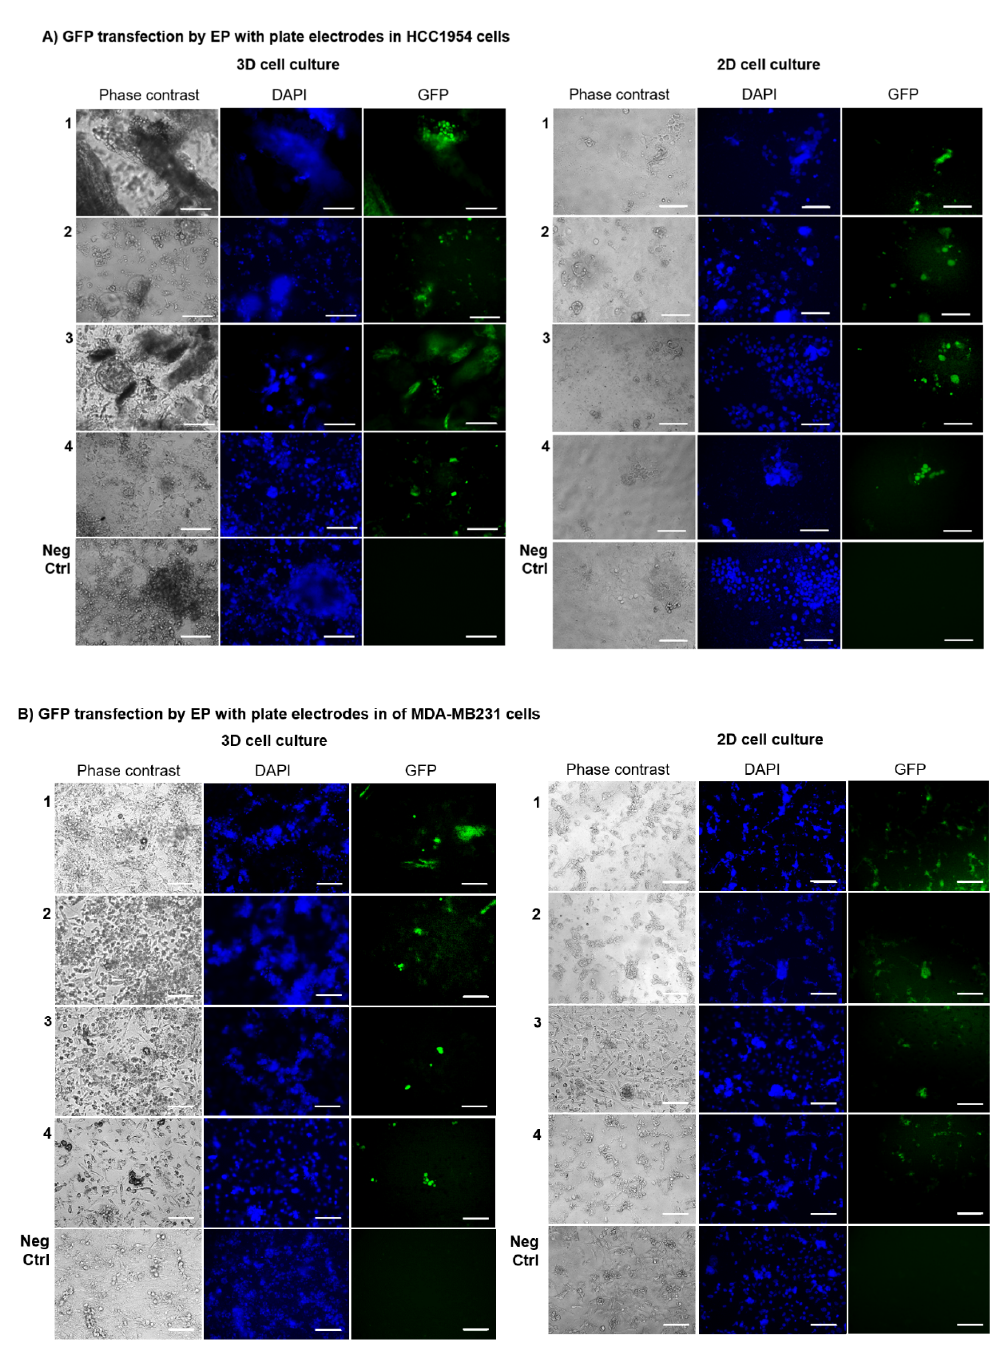
Figure 5. The e ffi ciency of di ff erent GET protocols in HCC1954 and MDA-MB231 3D and 2D cell cultures transfected by EP with plate electrodes. Representative fluorescence images of ( A ) HCC1954 and ( B ) MDA-MB231 3D and 2D cell cultures transfected with GFP by EP with plate electrodes. Observation at three days post-transfection. Representative micrographs of cells in bright field and using DAPI and GFP filters. Micrographs are representative of two separate blind experiments with similar outcomes. Not transfected cells are the Negative Control (Neg Ctrl). Magnification 20 × . Scale bars, 100 µ